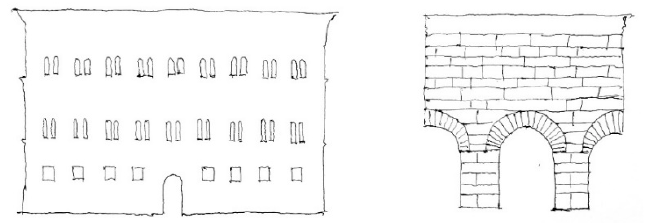
Figure 3. Voids of different scales define different layers. The windows and joints of Palazzo Strozzi in Florence, Italy.